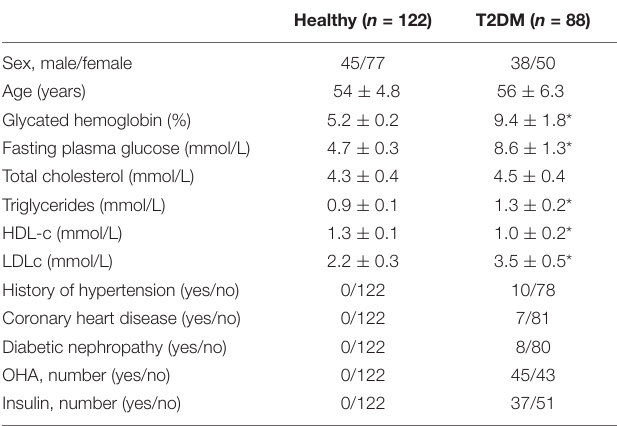
TABLE 1 | Characteristics of subjects in this